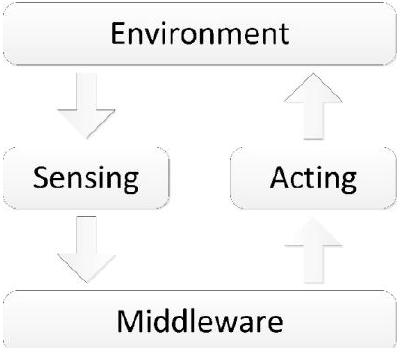
Figure 2. Information cycle of the AAL